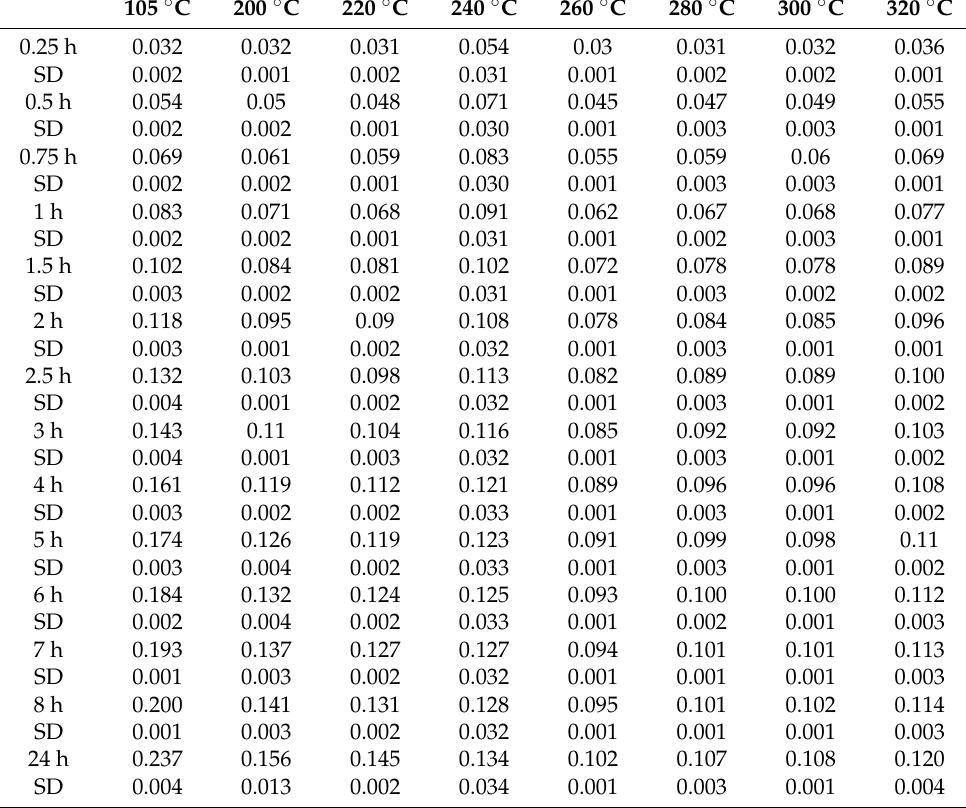
Table 5. Influence of the climatic chamber operation time and the torrefaction temperature on the value of the EMC coefficient for mandarin